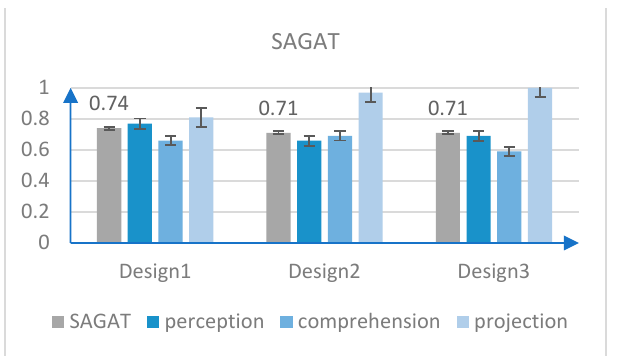
Figure 7. Scores from the SAGAT questionnaire. The first column of each design is the SAGAT score, and the next three columns are its three-dimensional scores.